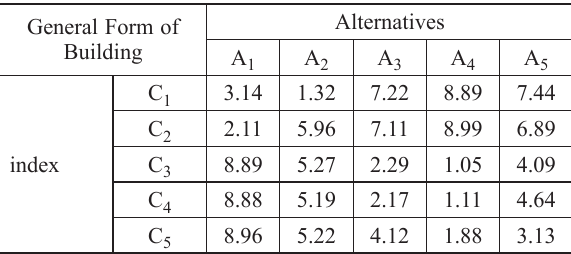
Table 11. Averages of experts’ scores for alternatives of combination of building forms within the major indexes